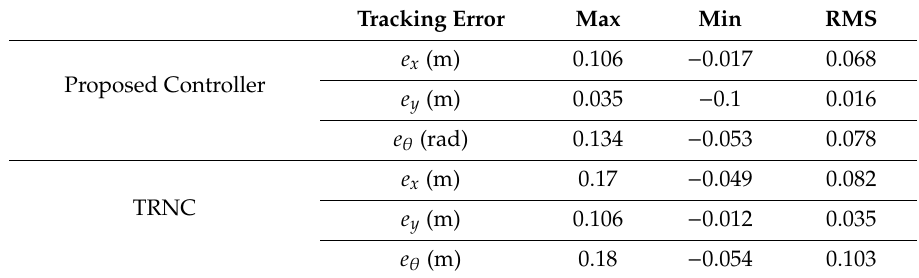
Table 3. Comparative results between two controllers (max, min, and root mean square (RMS) value of tracking